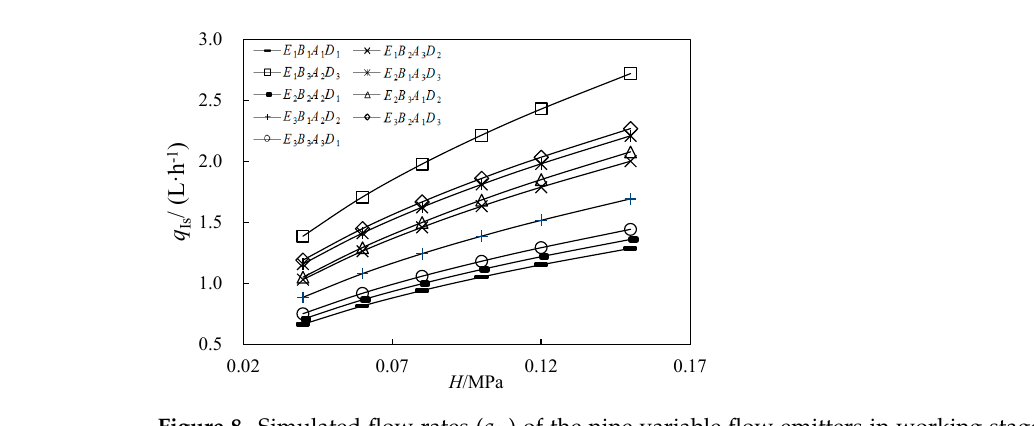
Figure 8. Simulated flow rates ( q Is ) of the nine variable flow emitters in working stage I and the working pressure ( H ). Table 3. The simulated flow rates at H = 0.1 MPa ( q Is0.1 ) and the simulated flow indexes ( x s ) of the variable flow emitter in working stage I.